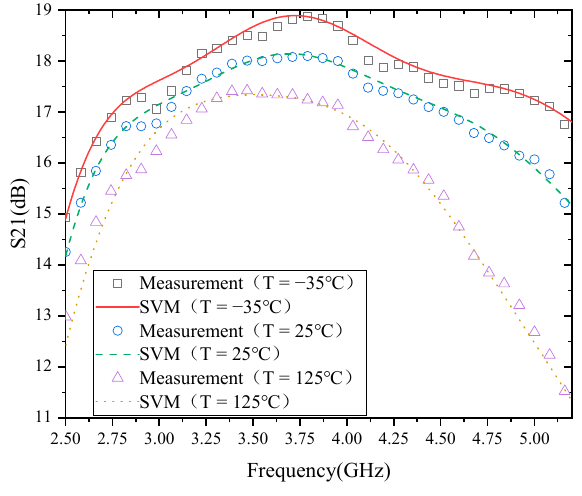
Figure 6. Modeling results of S21.